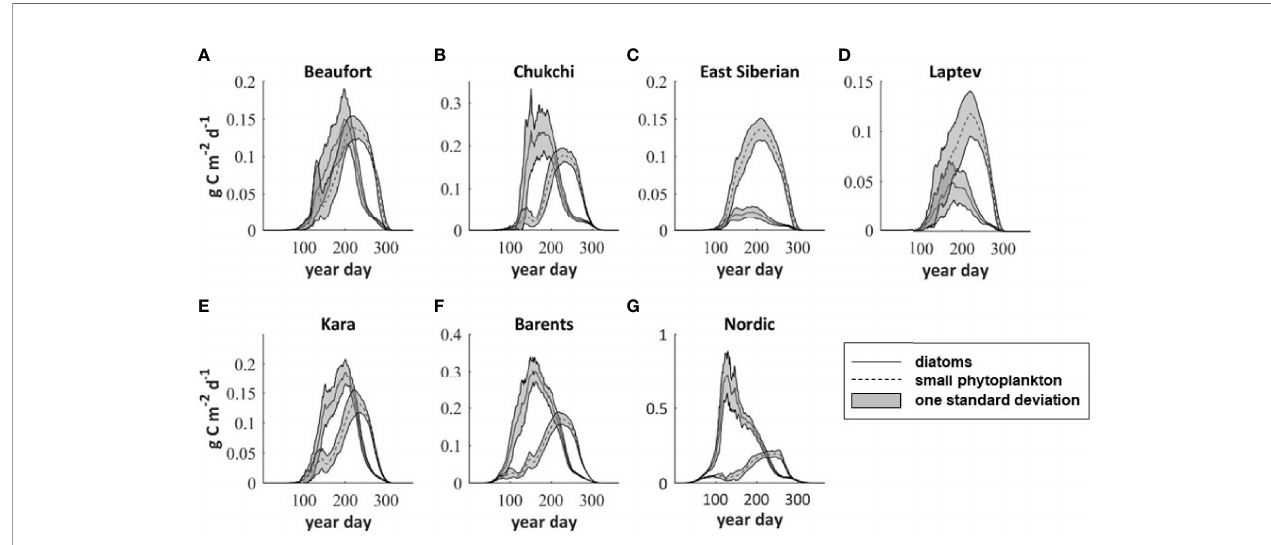
FIGURE 7 | Regionally averaged seasonal cycle of primary production by group (diatoms and small phytoplankton) in the baseline model run for (A) Beaufort Sea (R1), (B) Chukchi Sea (R2), (C) East Siberian Sea (R3), (D) Laptev Sea (R4) (E) Kara Sea (R5), (F) Barents Sea (R6) and (G) Nordic Seas (R7). The grey shading indicates ± one standard deviation.